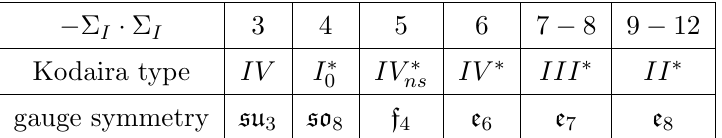
56 , while for the rational curves with 2